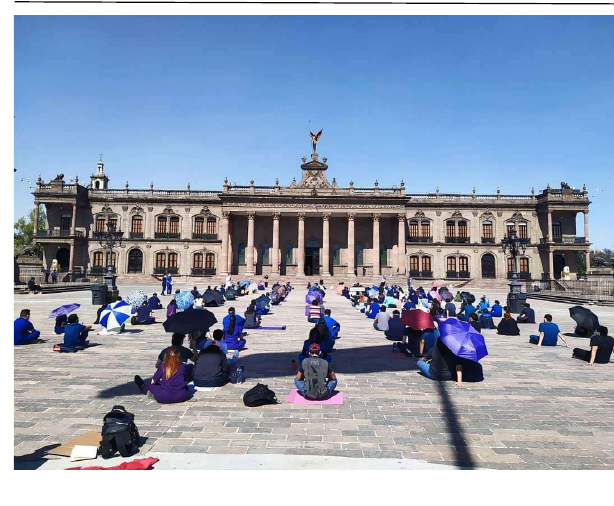
Figure 2. Medical Students in Front of the Monterrey City Hall (rear